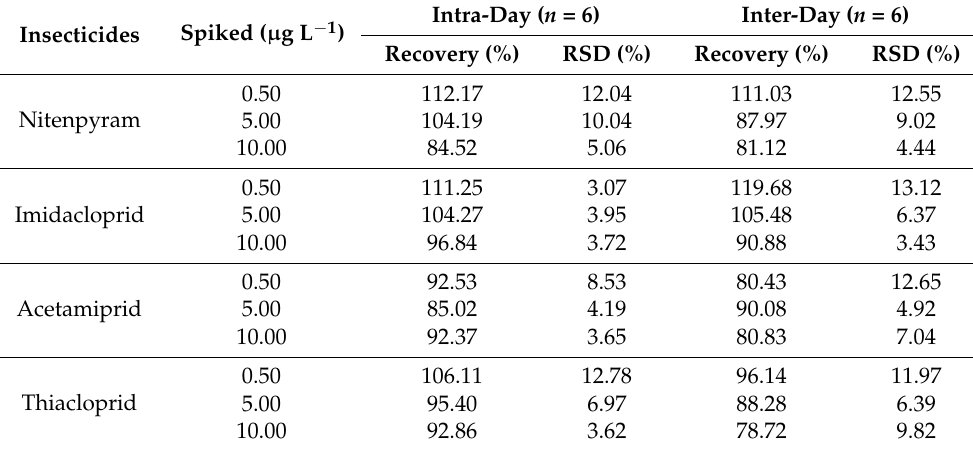
Table 1. Regression equation, linear range, correlation coefficient ( r 2 ) and method detection limit, and limit of quantification of four neonicotinoid insecticides.